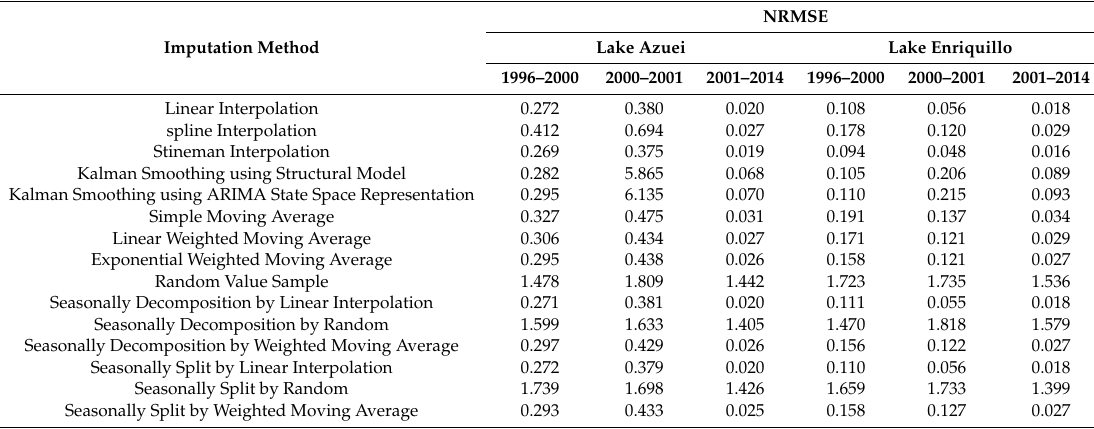
Table 1. The Normalized Root Mean Squared Error (NRMSE) of imputation results.